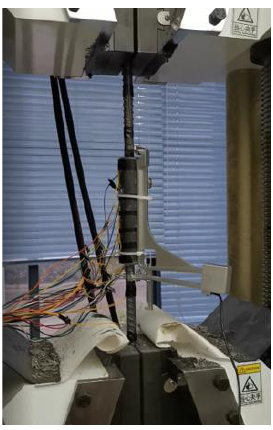
Figure 9. Experimental equipment.